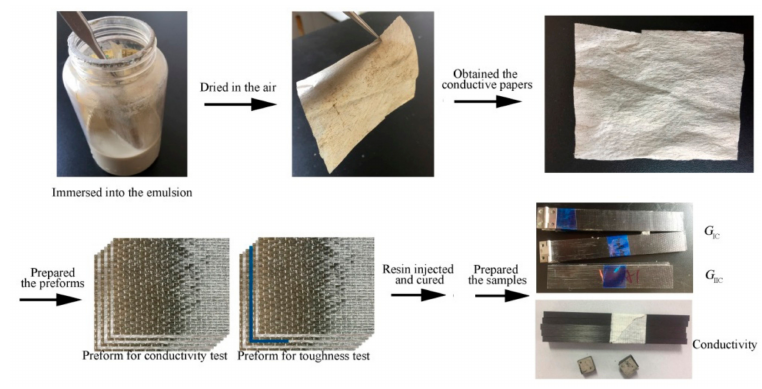
Figure 1. Schematic diagram of preparation of conductive papers, composite laminates and test specimens.